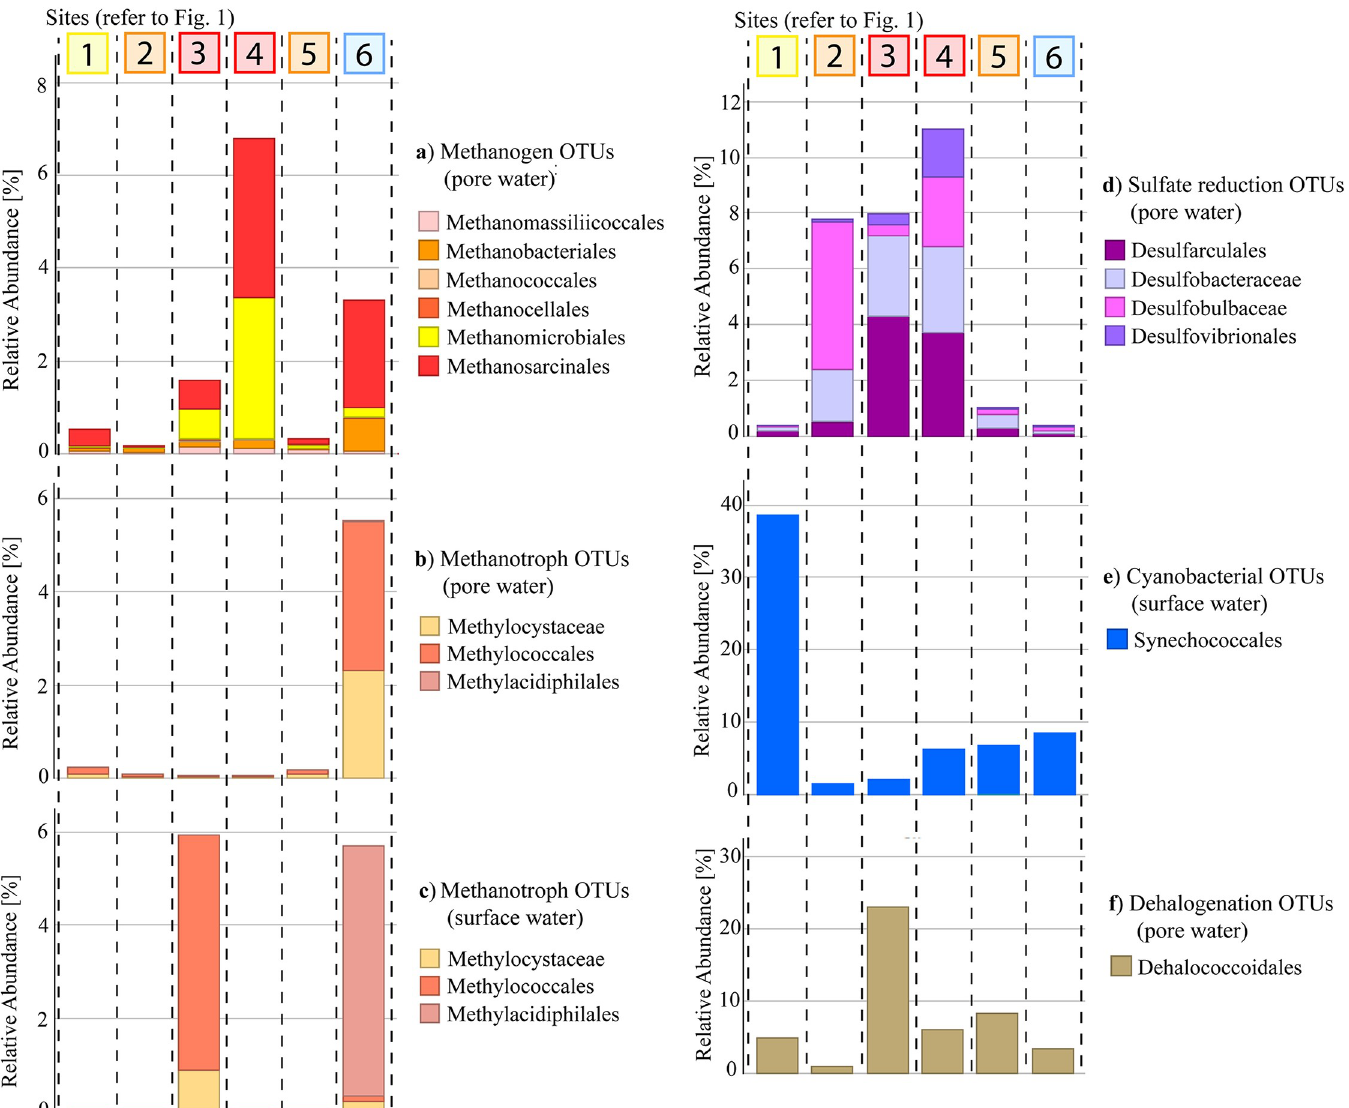
Fig 6. The relative abundances of select environmental OTUs along a land use gradient in the Burnett River estuary. Functional groups were combined in the stacked bar plots.